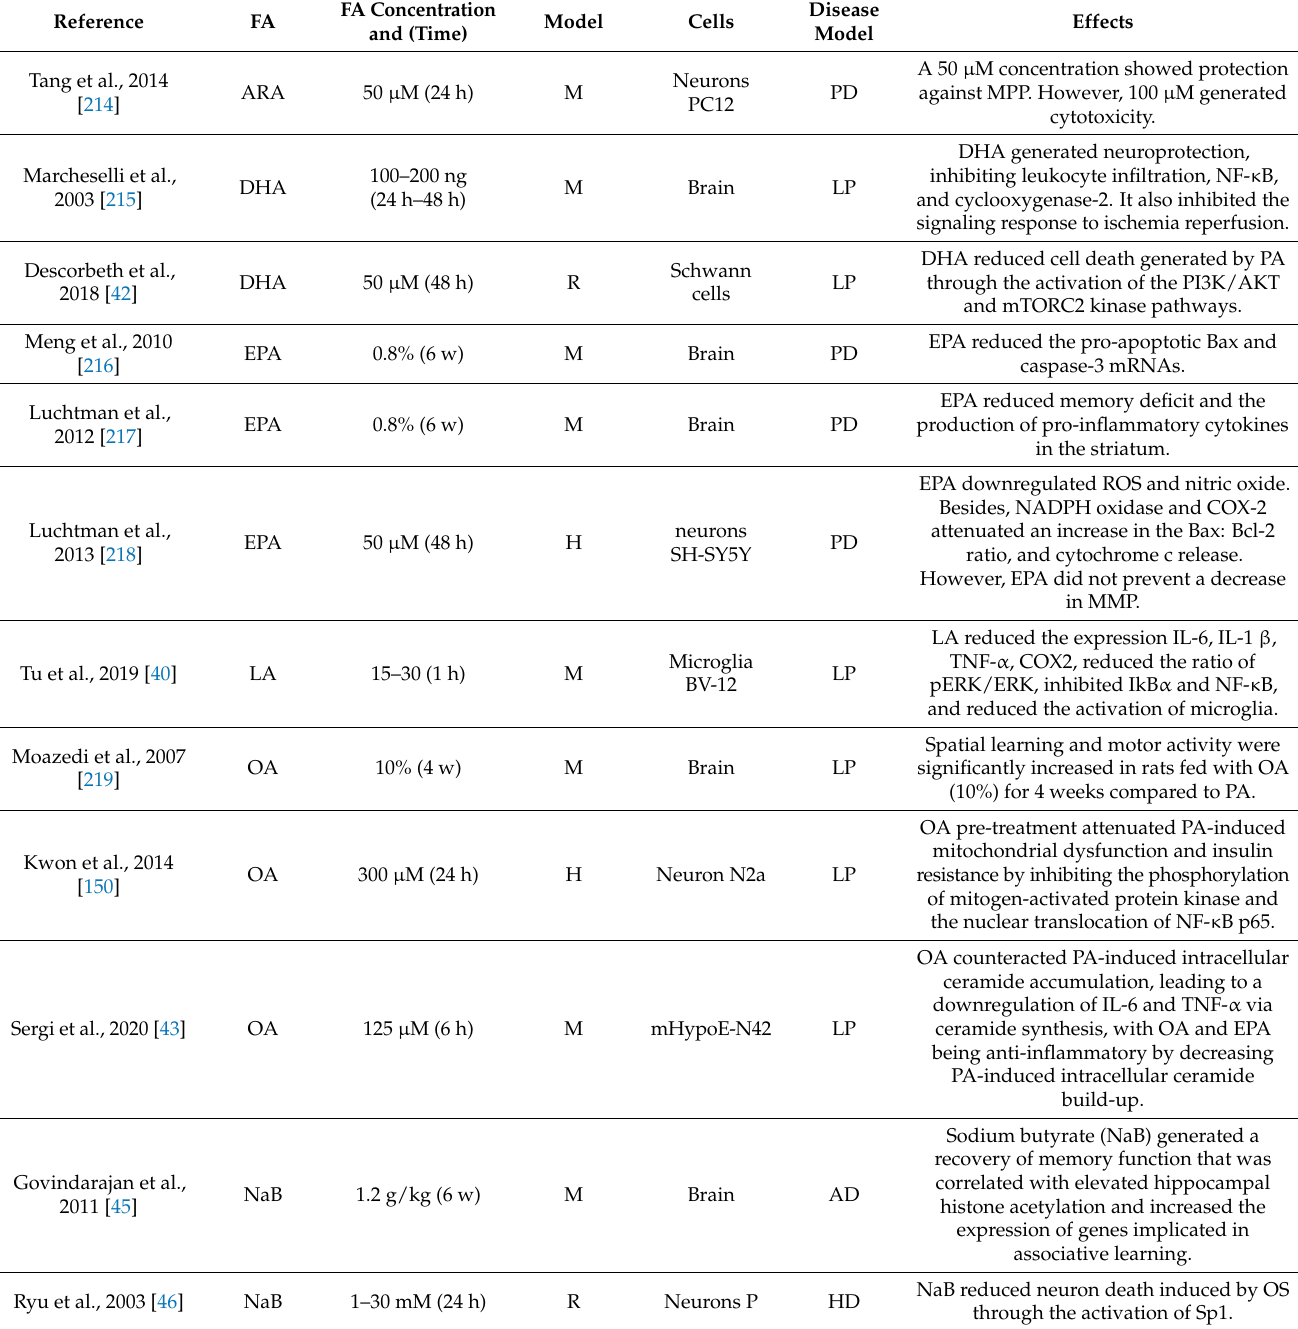
Table 3. Fatty acids (FAs) with protective effects in the brain against palmitic acid (PA)-induced